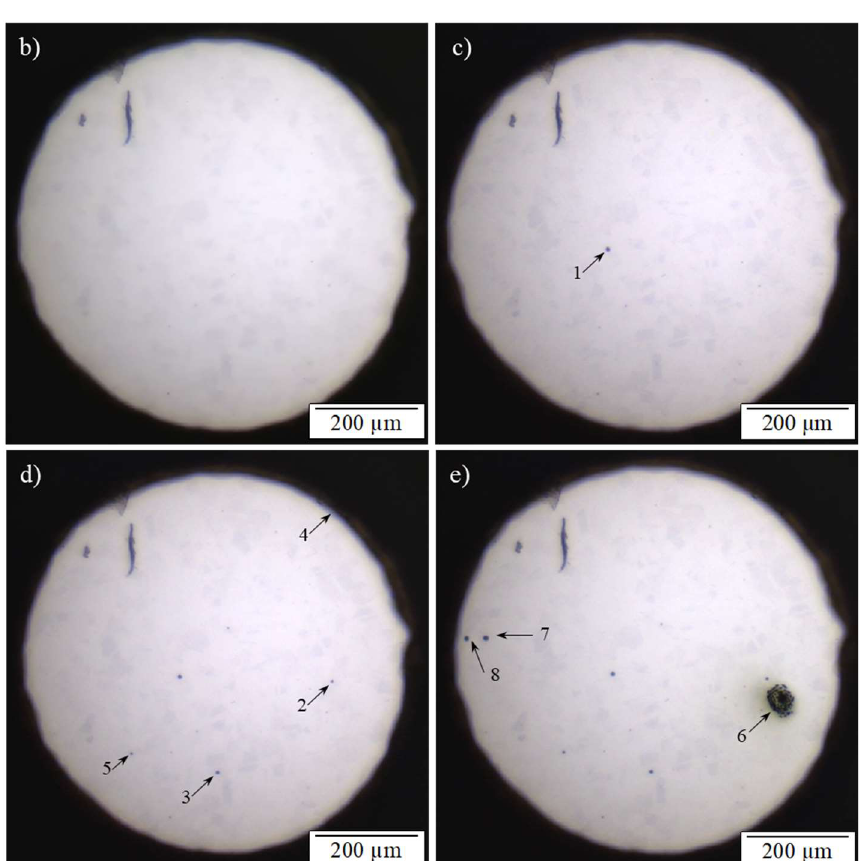
Figure 5. Electrochemical results and four frames out of a video of the in situ microscopic analysis of the 1.4301 at a chloride ion concentration of 500 mg/L and a test area diameter of 0.5 mm. ( a ) Current density-potential curve; ( b ) start of the video at 0 s (220 mV); ( c ) video after 196 s (416 mV); ( d ) video after 360 s (580 mV); ( e ) video after 515 s (735 mV).